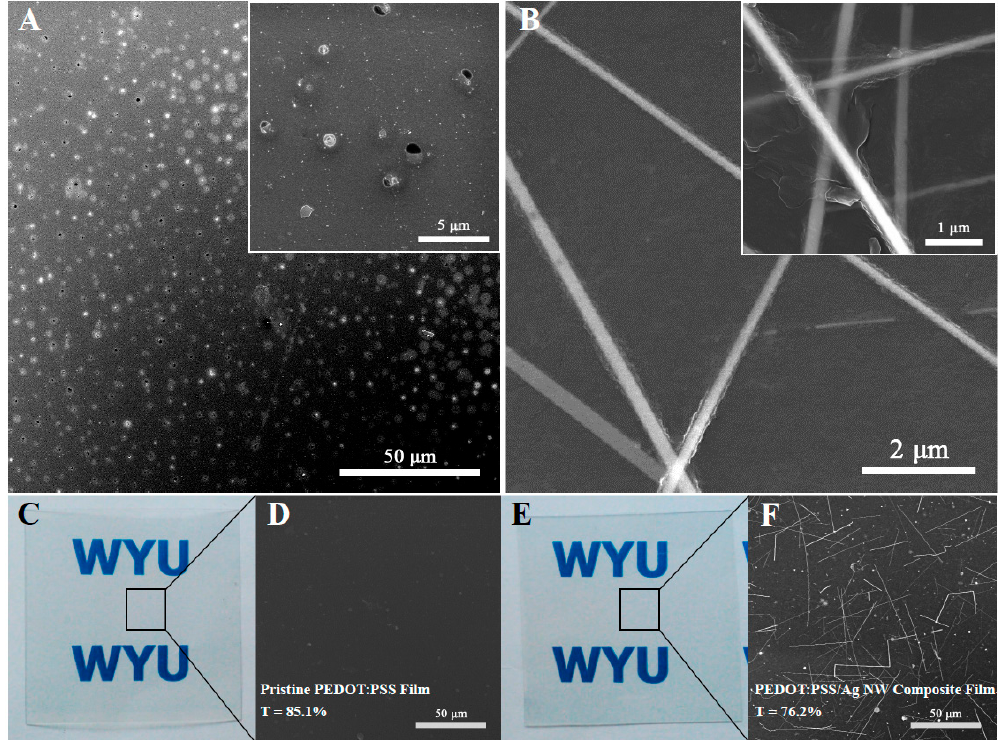
Figure 2. SEM images of PEDOT:PSS film using a 420 mesh ( A ) and PEDOT:PSS/Ag NW film using a 350 mesh ( B ); the insets were magnified images. Photographs ( C , E ) and SEM images ( D , F ) of pristine PEDOT:PSS and PEDOT:PSS/Ag NW film printed using a 350 mesh, and the added Ag NW concentration was 8 mg/mL.